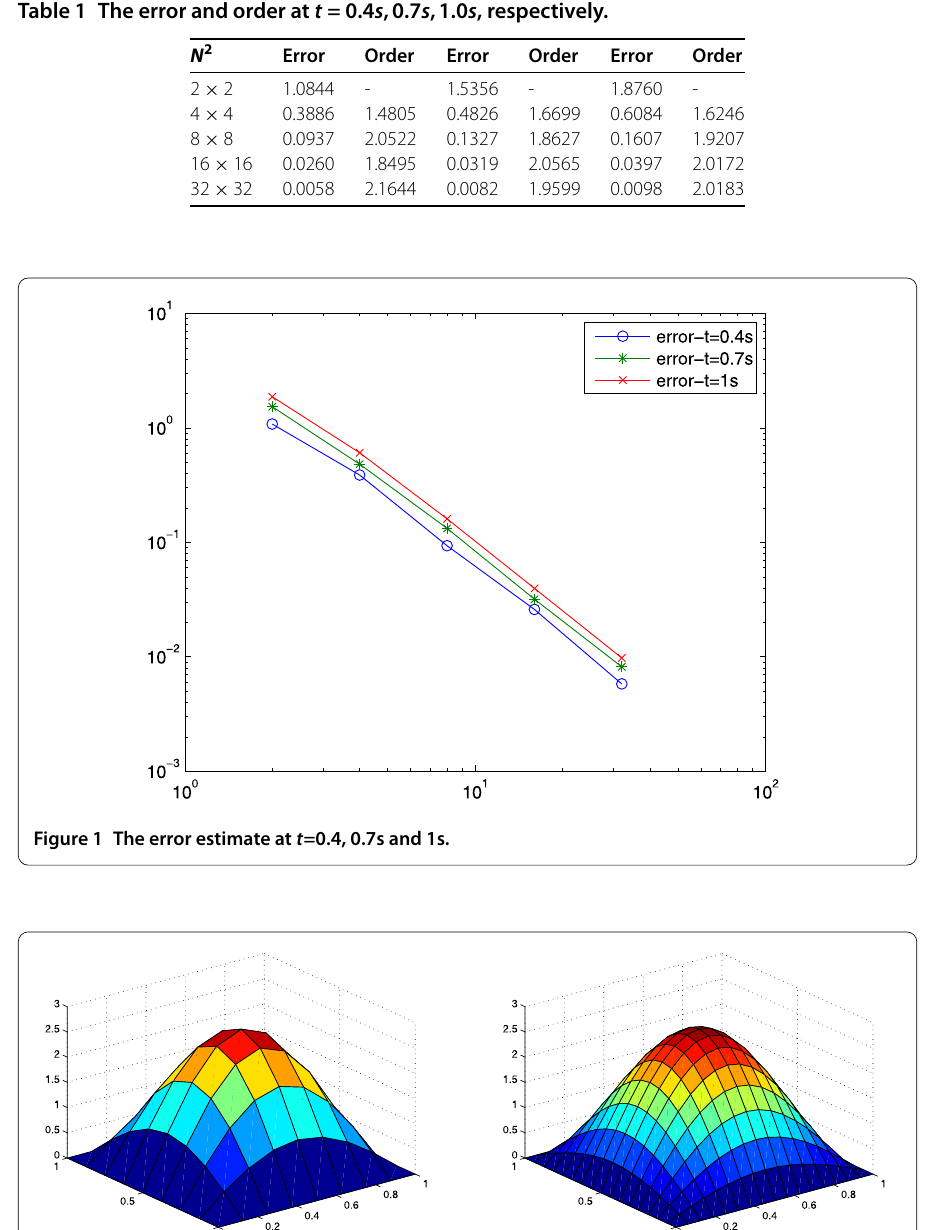
and h = 1 , respectively. 8 16